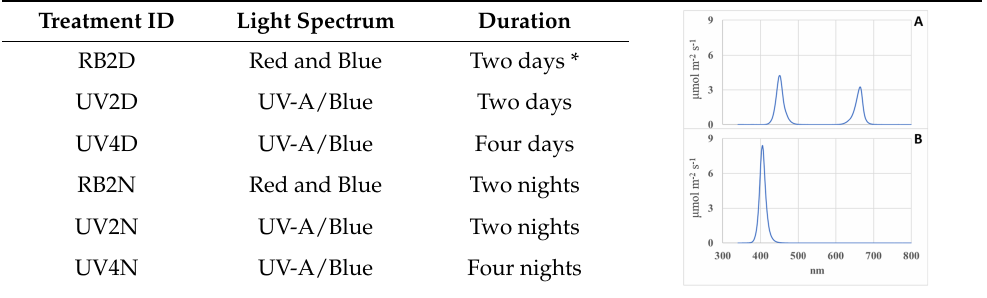
Table 2. The six pre-harvest supplemental lighting treatments used in Experiments 1 and 2. The Red and Blue spectrum (Figure A) was 44% red with a peak at 665 nm and 56% blue with a peak at 450 nm. The UV-A/Blue spectrum (Figure B) was 24% UV-A and 76% blue with a peak at 403 nm. All treatments had equal light intensity of 171 µ mol m − 2 s − 1 . Treatment ID Light Spectrum Duration RB2D Red and Blue Two days * UV2D UV-A/Blue Two days UV4D UV-A/Blue Four days RB2N Red and Blue Two nights UV2N UV-A/Blue Two nights UV4N UV-A/Blue Four nights